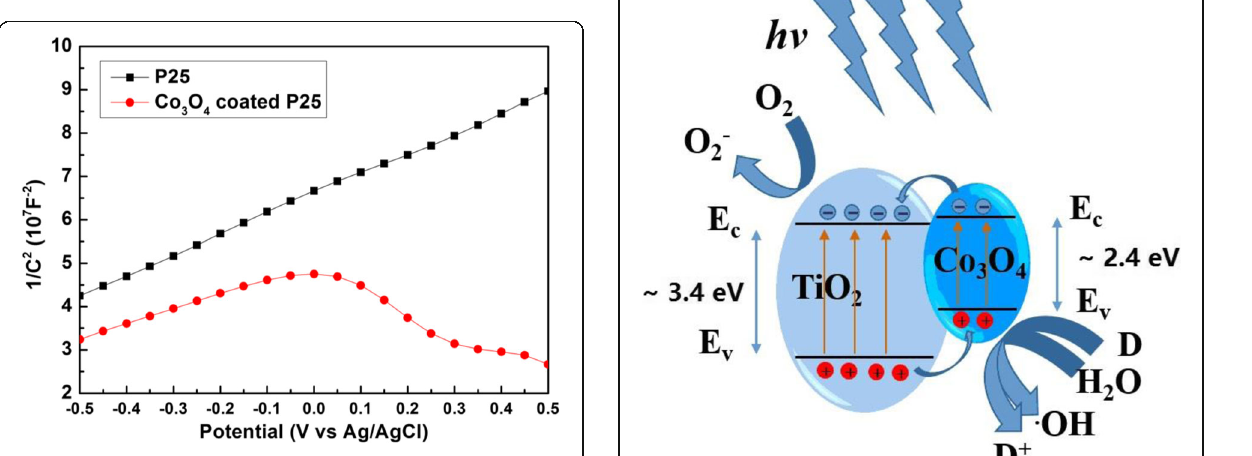
Fig. 6 Mott-Schottky plots of pure P25 and Co 3 O 4 -coated P25 in 1 M NaOH aqueous solution with frequencies of 1 and 2 kHz in the